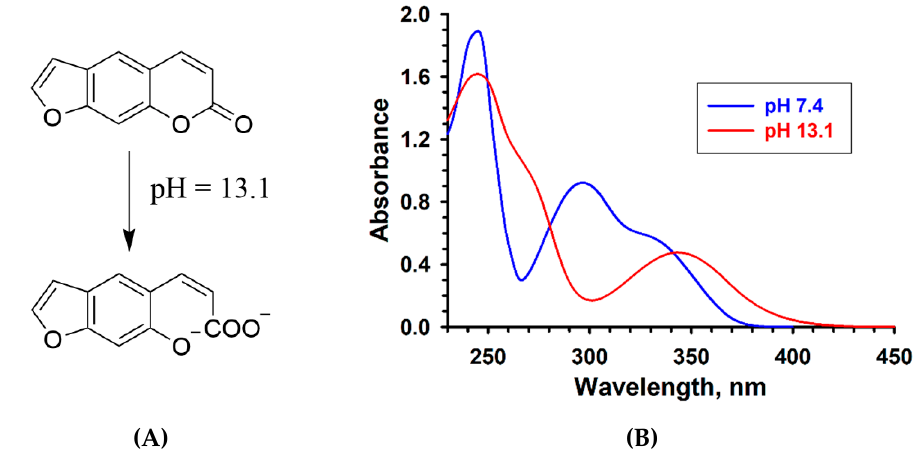
Figure 1. Psoralen pyrone ring-opening. ( A ) Reaction scheme. ( B ) UV-vis absorption spectra of 0.1 mM psoralen solution in PBS (pH 7.4, 1% of ethanol) and after alkalizing to pH 13.1.